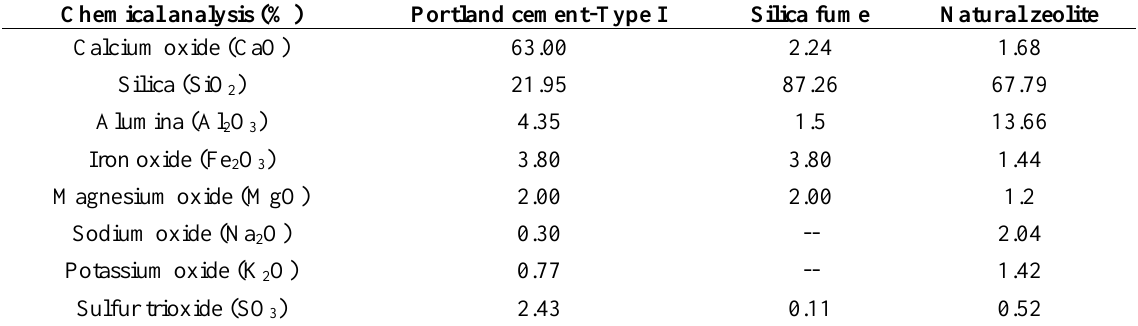
Table 1. Chemical composition of cementitious materials Chemical analysis